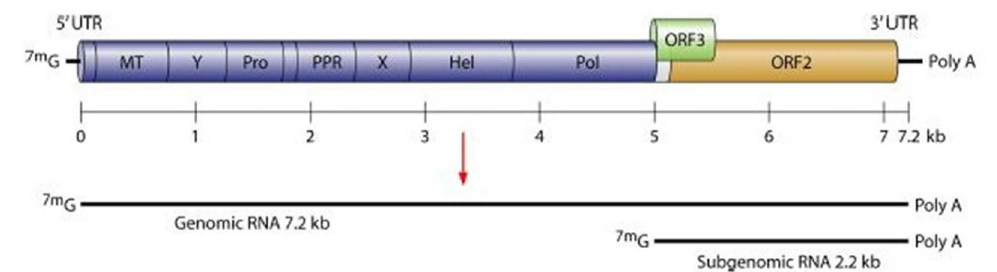
Fig. 1. Hepatitis E virus genome. Where, MT= Methyltransferase; Pro= Cysteine protease; PPR= Proline- rich hinge domain Hel= RNA helicase; Pol= RNA- dependent RNA polymerase; X= Macrodomain